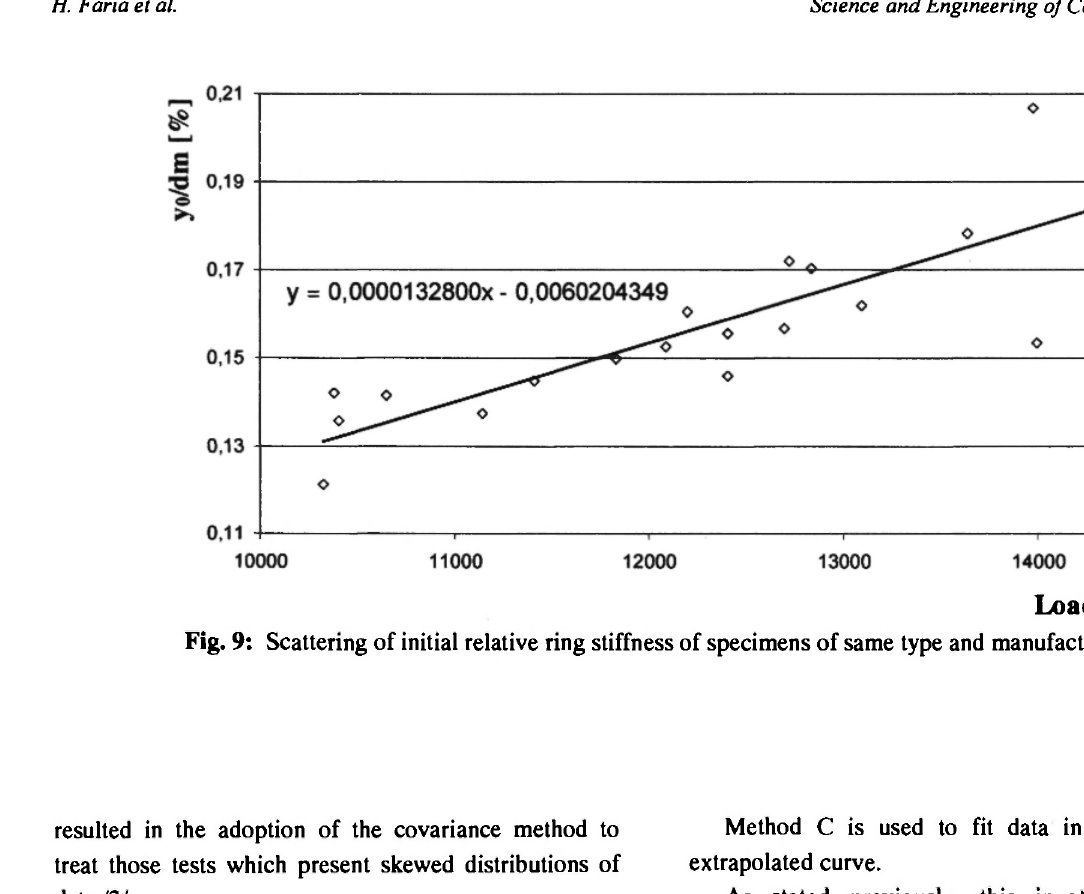
resulted in the adoption of the covariance method to treat those tests which present skewed distributions of data